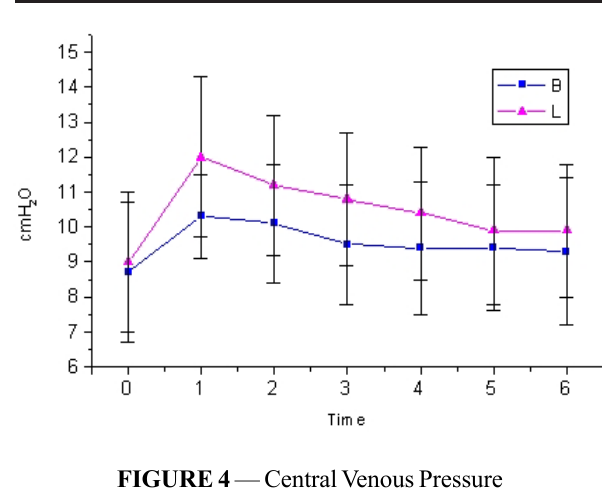
FIGURE 4 — Central Venous